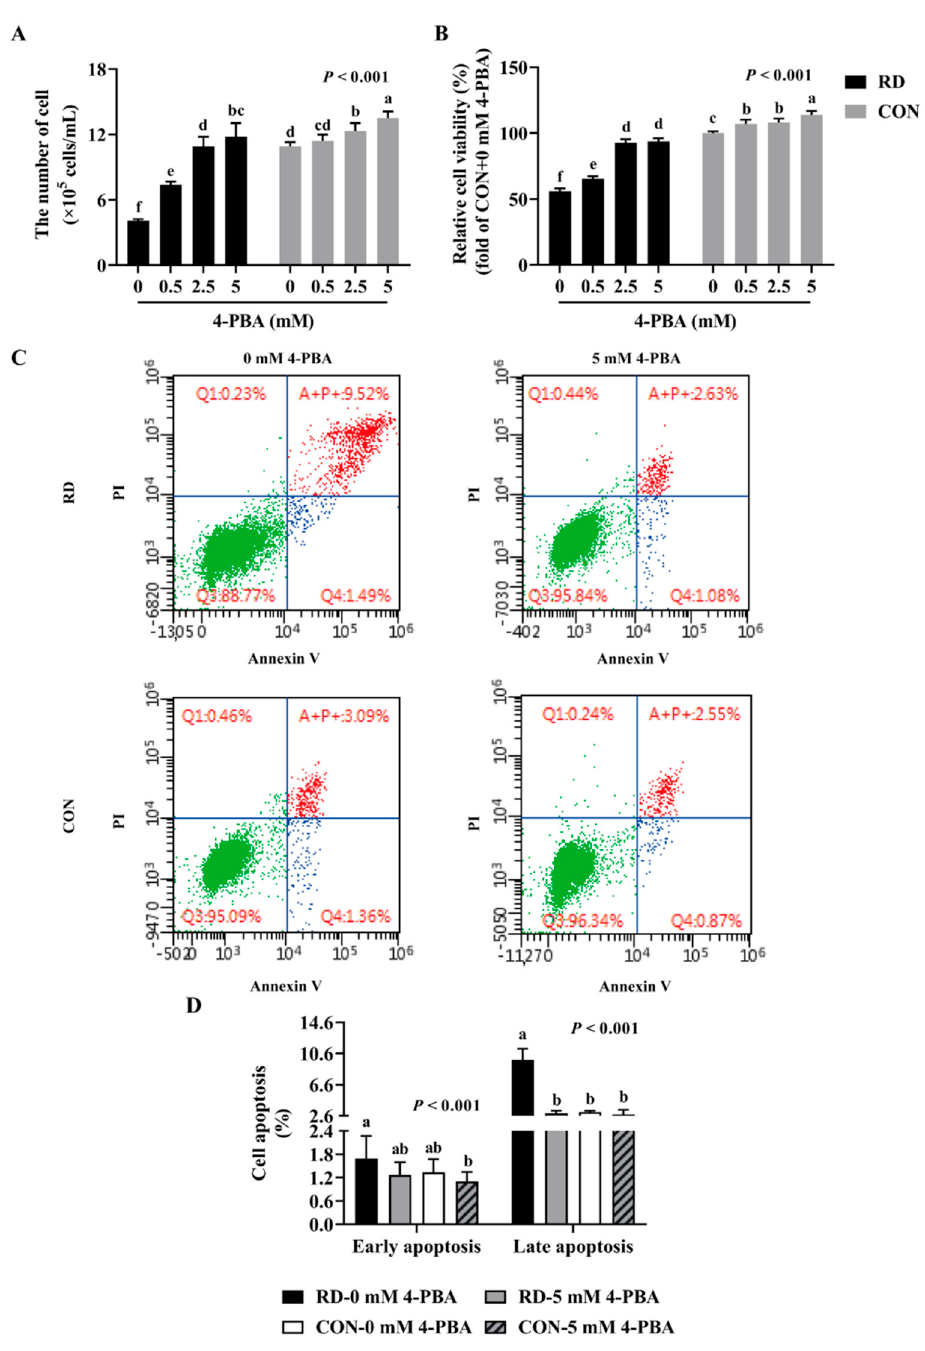
Figure 6. 4-phenyl butyric acid (4-PBA) can prevent RD-induced cell apoptosis. Effect of different concentrations (0, 0.5, 2.5, and 5 mM) of 4-PBA on cell number ( A ) and relative cell viability ( B ) in riboflavin-deficient cells. ( C ) Effect of RD on cell apoptosis following treatment with 4-PBA (5 mM) in HepG2 cells. ( D ) Results of cell apoptosis analysis. Different letters indicate significant differences ( p < 0.05). Each treatment is performed in six replicates (n = 6).